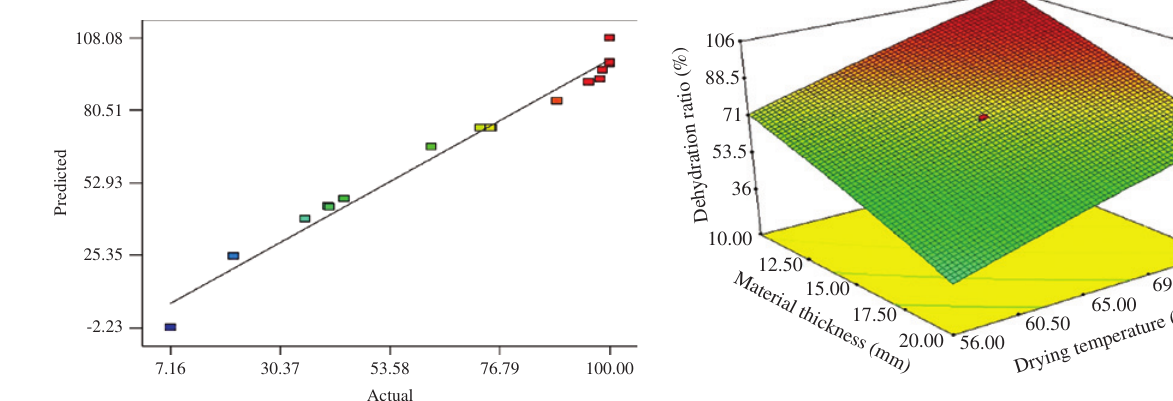
Figure 2: Predicted vs. experimental relative dehydration ratio.